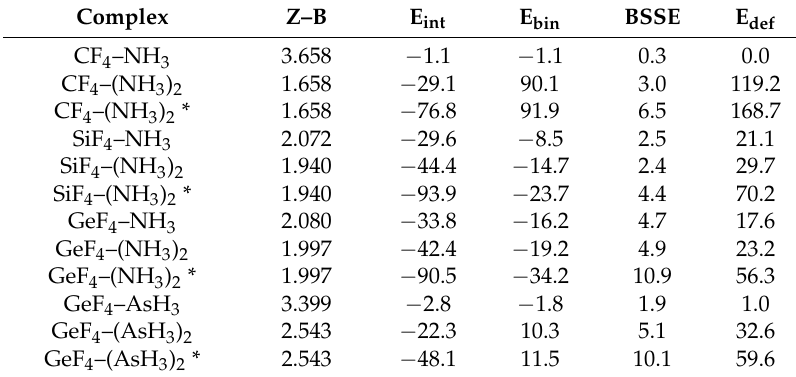
Table 1. The energetic parameters (in kcal/mol); the interaction energy, E int , and the binding energy, E bin , corrected for BSSE, the deformation energy, E def . The tetrel–Lewis base centre distances are included, Z–B (i.e., Z–N or Z–As, Z = C, Si, Ge, in